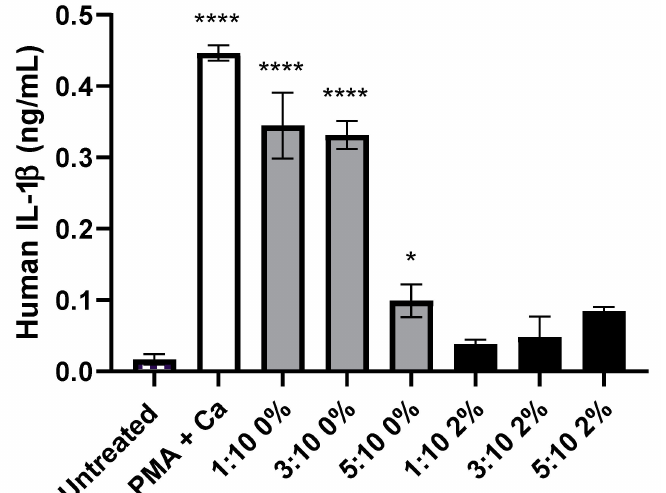
Figure 8. Quantity of IL-1B released by KU812 cells following incubation alongside named materials for 24 h. * denotes p < 0.05. **** denotes p < 0.0001. Chequered bar represents negative control (untreated), white represents conditions of PMA and calcium ionophore, grey representing liposomes without PEG conjugation, and black with 2% PEG